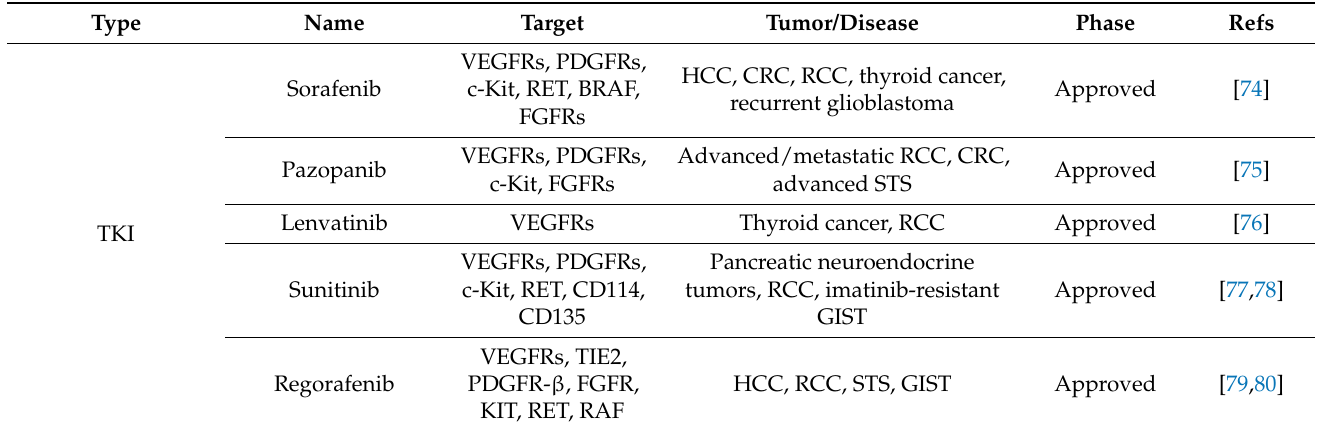
Table 2. Therapeutic agents of interest for anti-lymphangiogenic strategies in